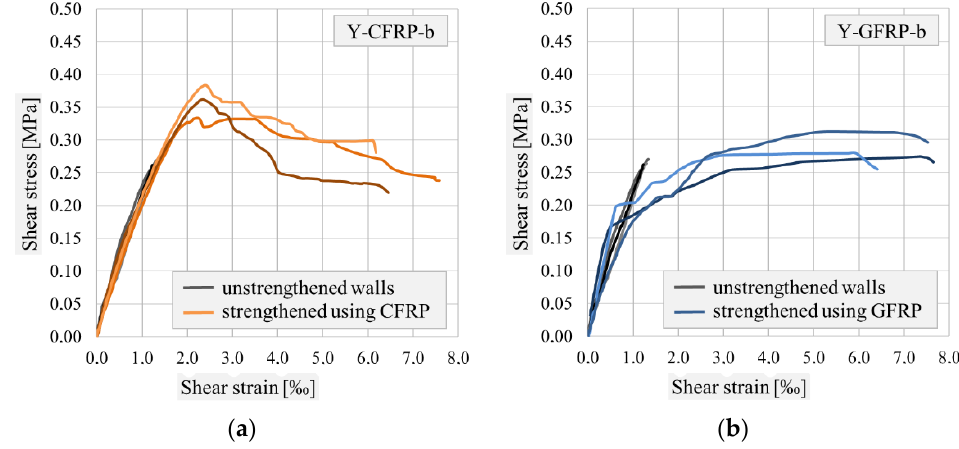
Figure 7. The stress–strain relationships for the wallets strengthened in configuration ‘a’ and un-